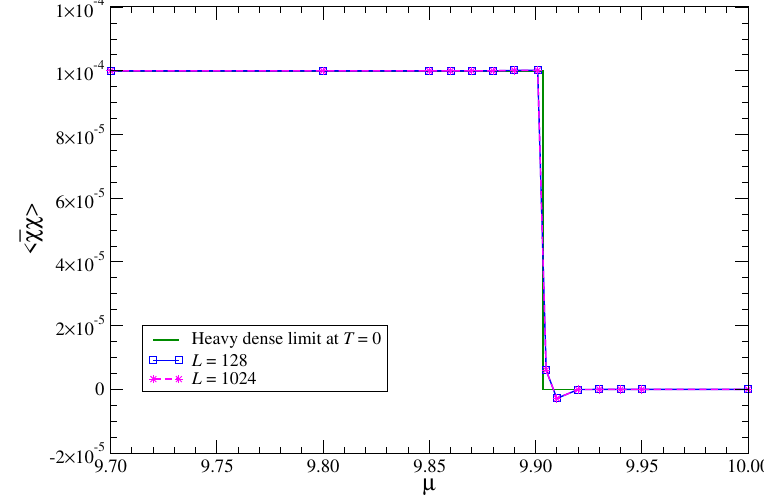
Figure 3 . Number density at m = 10 4 and g 0 = 32 on 128 4 and 1024 4 lattices as a function of µ with D = 30 . ∆ µ = 4 . 0 × 10 − 3 in the vicinity of µ c . Green line denotes the step function in eq. (3.1).